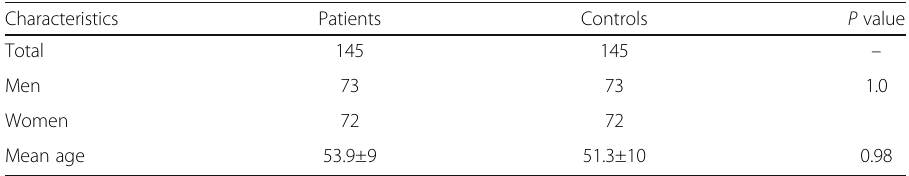
Table 1 Characteristics of study